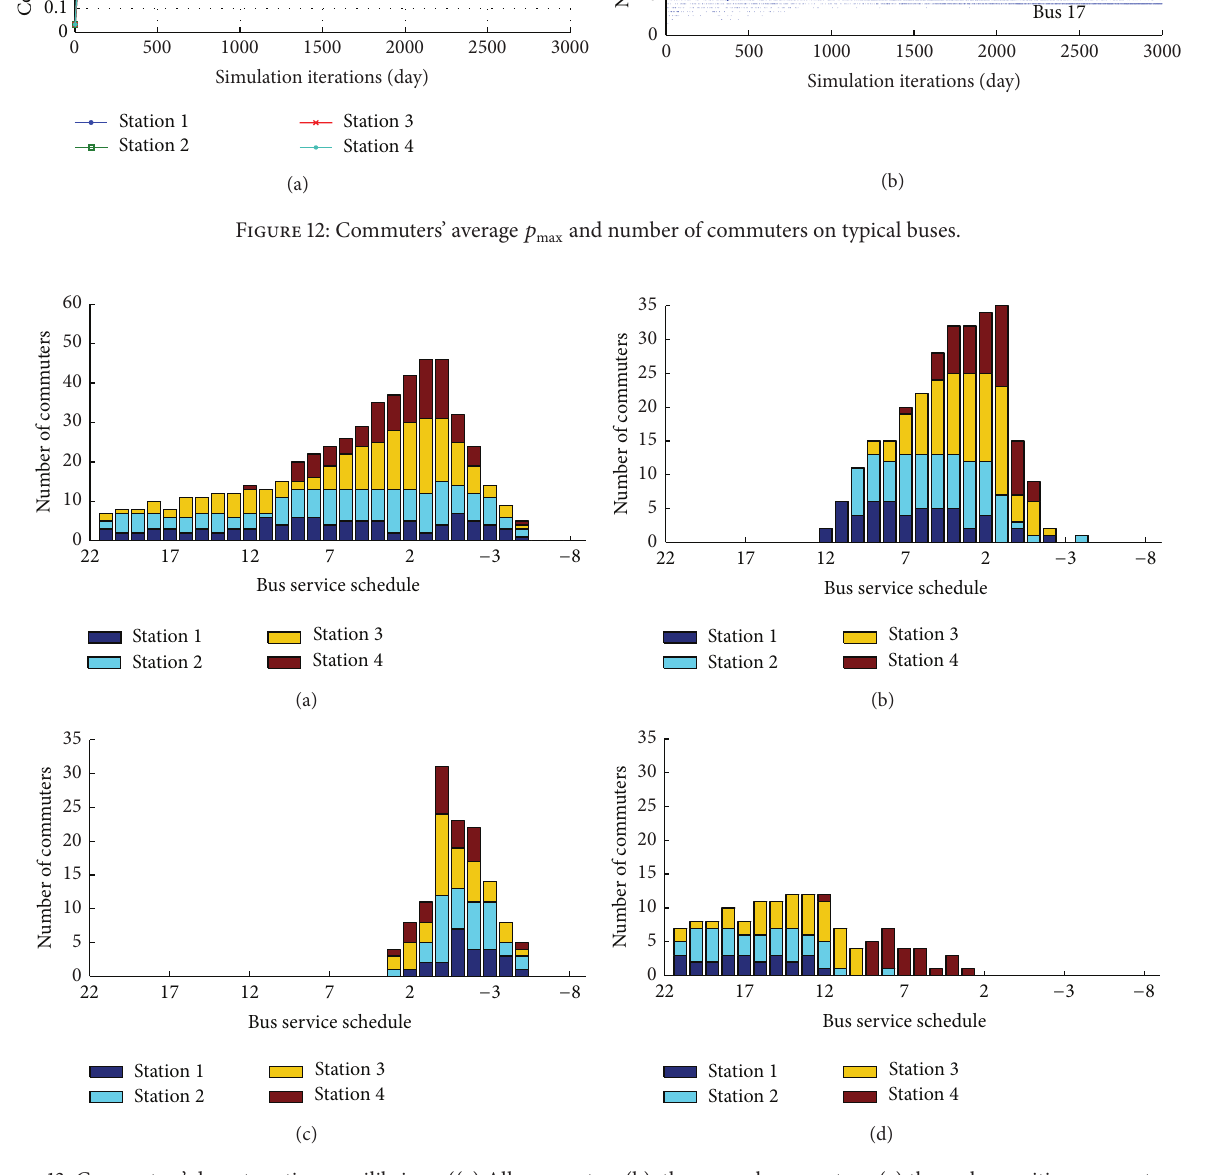
Figure 13: Commuters’ departure time equilibrium. ((a) All commuters (b), the normal commuters, (c) the early-sensitive commuters, and (d) the late-sensitive